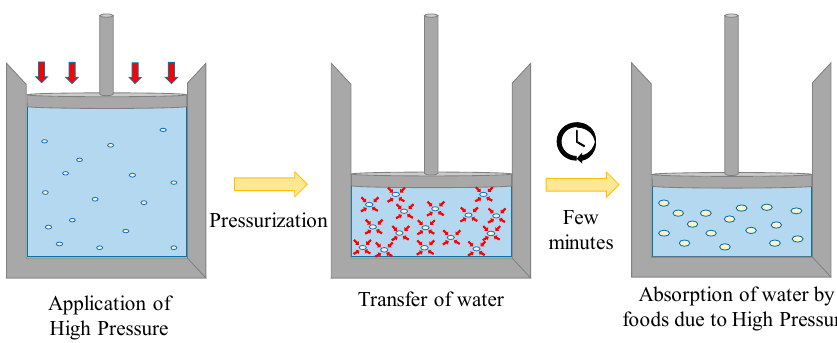
Figure 7. Representation of forced water absorption by foods under high pressure.